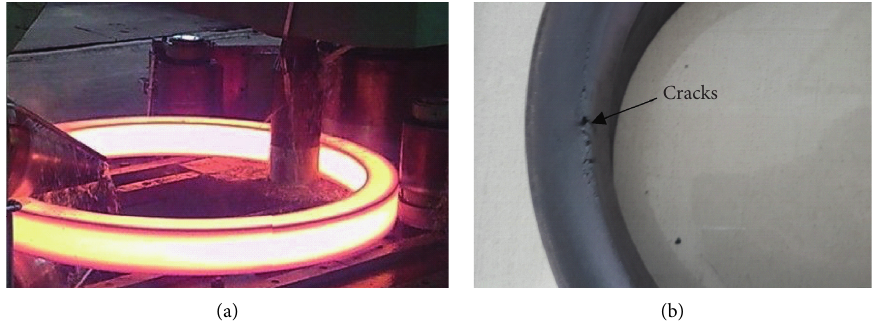
Figure 17: Cracking of ring in the hot ring rolling experiment. (a) Hot ring rolling experiment. (b) Cracking of the